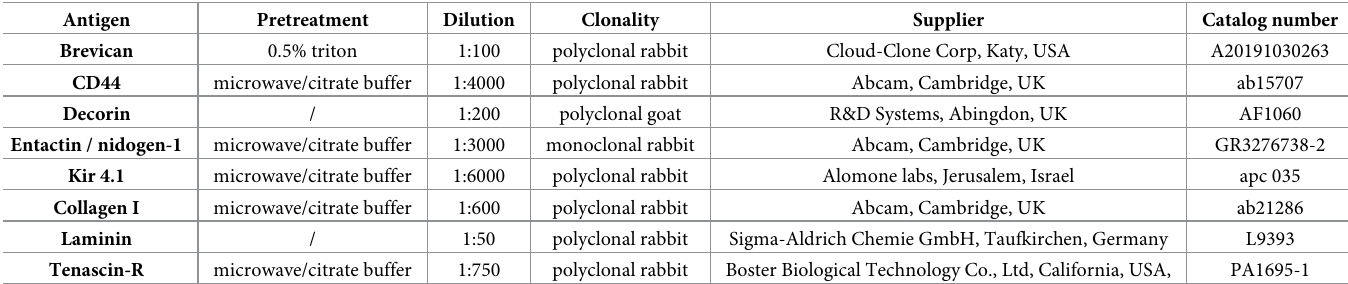
Table 1. Primary antibodies, pretreatment and dilutions used for